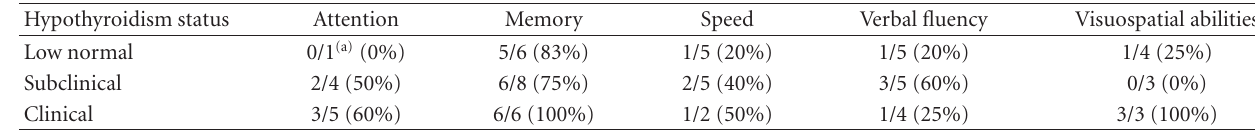
Table 6: Continuum of specific cognitive defects with the degree of